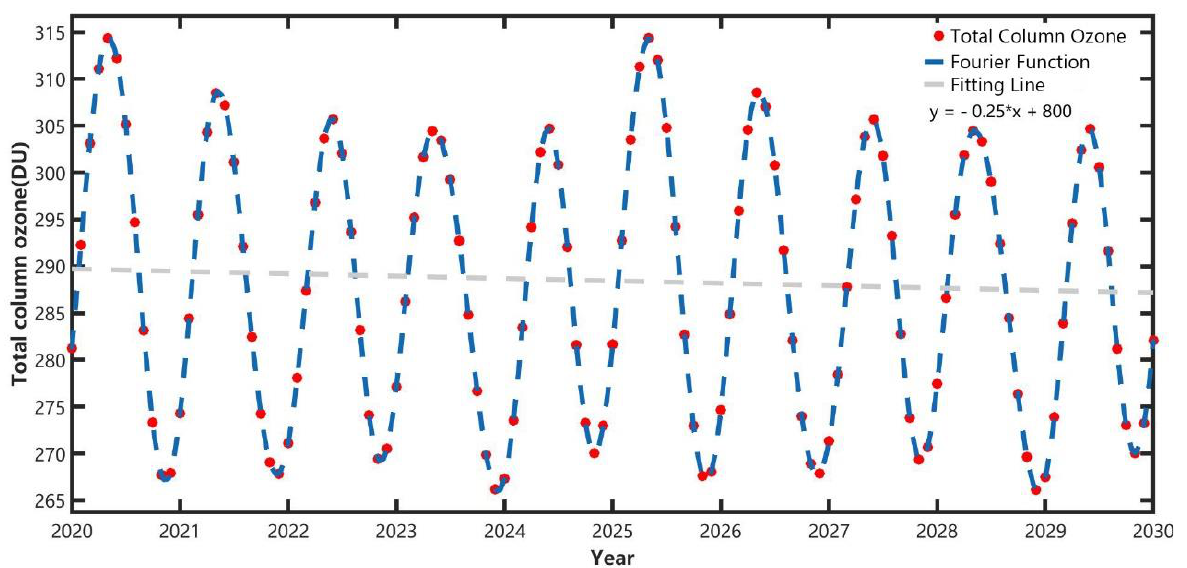
19 of 22 Figure A7. Fourier function fit plots of historical results of monthly changes in the TCO for the